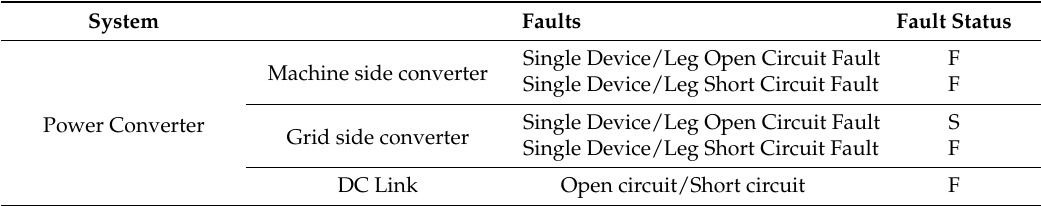
Figure 5. Single-phase rotor winding fault for a 250-MW DFIM unit. Table 1. Survivability status for power converter faults [13,30].